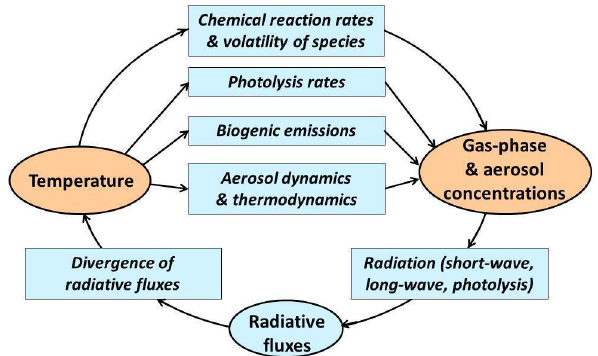
Fig. 2. Conceptual model of impacts from temperature on concen- trations and vice